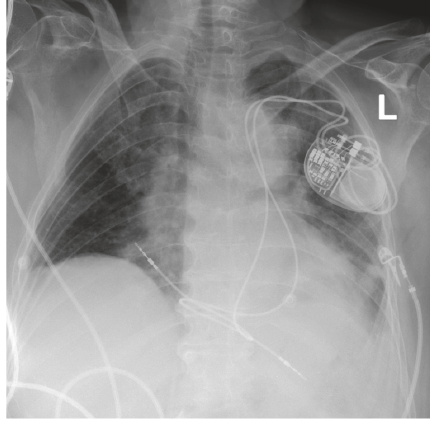
Figure 2: Chest X-ray showing final position of pacemaker and